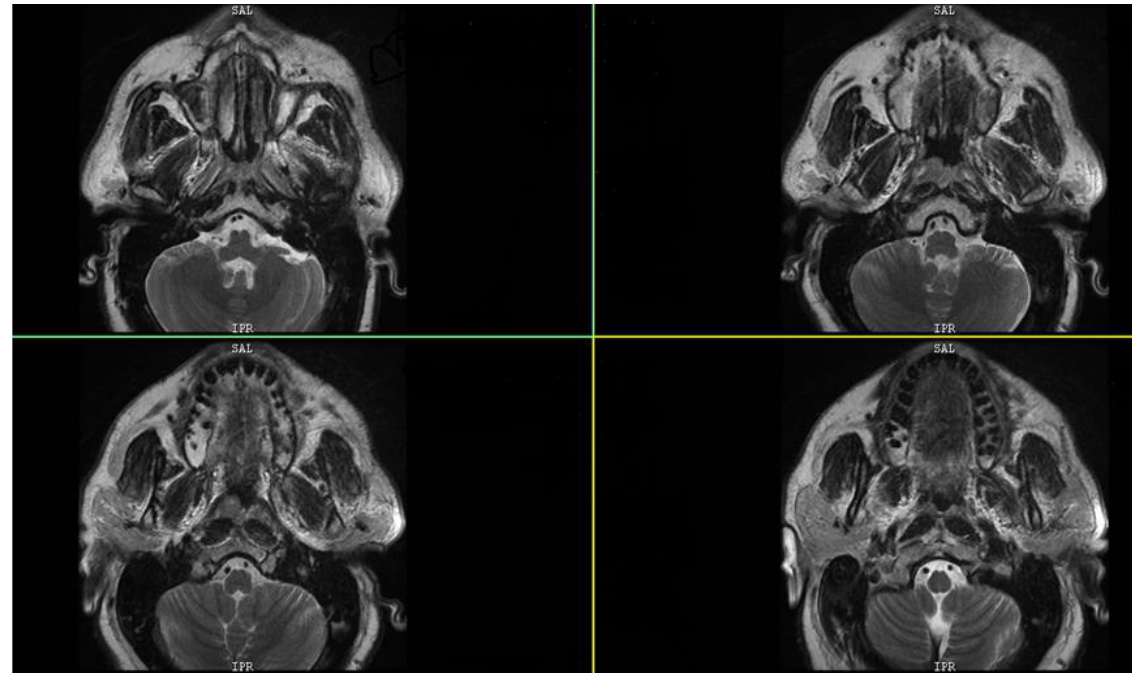
Figure 2. T1 axial imaging with Post gadolinium enhancement showing necrotic devitalized left inferior turbinate (hypointense black turbinate sign) with necrosed upper alveolar margin with mucosal thickening of the left maxillary